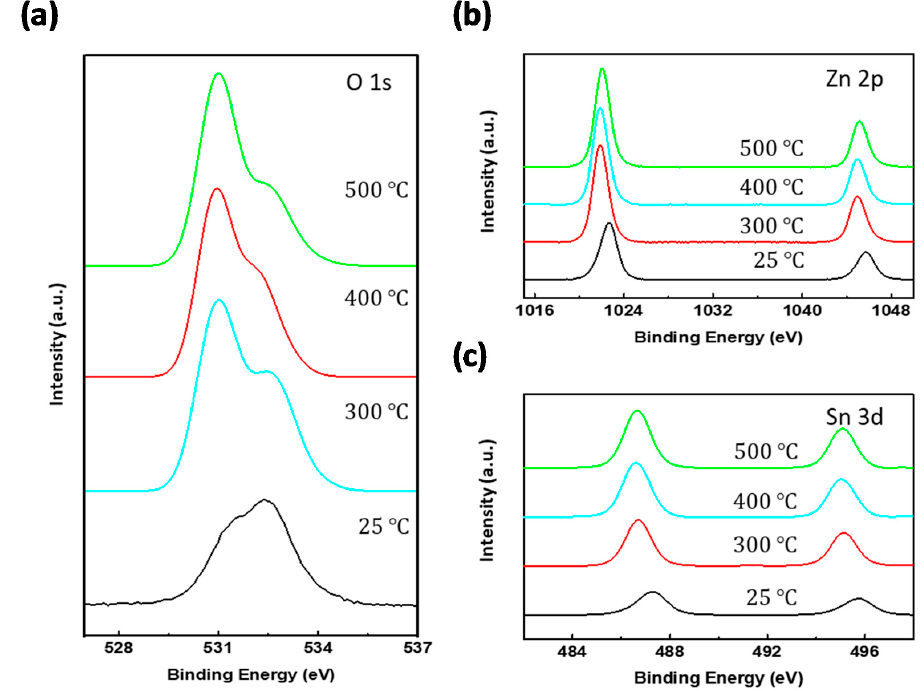
Figure 5. XPS spectra of the printed ZTO at various annealing temperatures: ( a ) O 1s, ( b ) Zn 2p, and ( c ) Sn 3d core